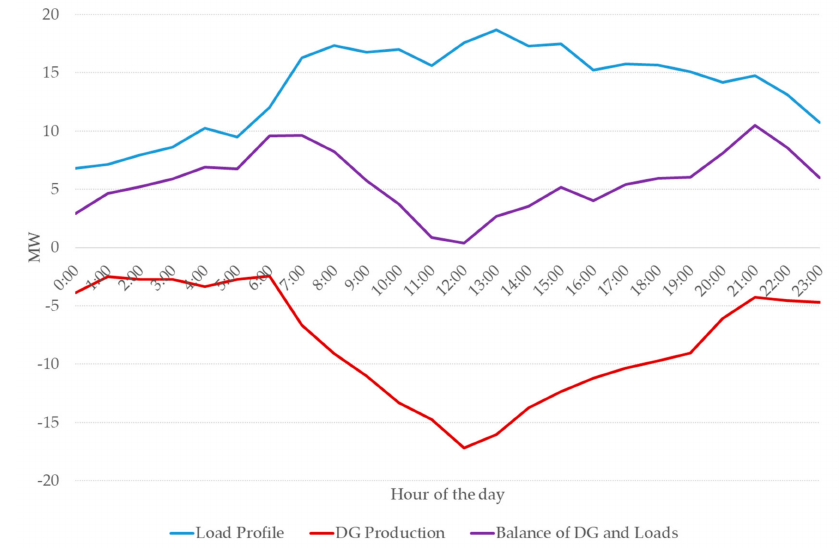
Figure 2. Load-production profiles of the whole network for the Spring working typical day.